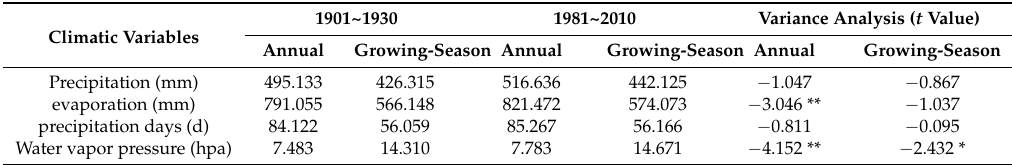
Table 2. The ANOVA comparison of climatic variables in the Songnen Plain between 1901–1930 and 1981–2010 in two intervals: annual (year-long) and